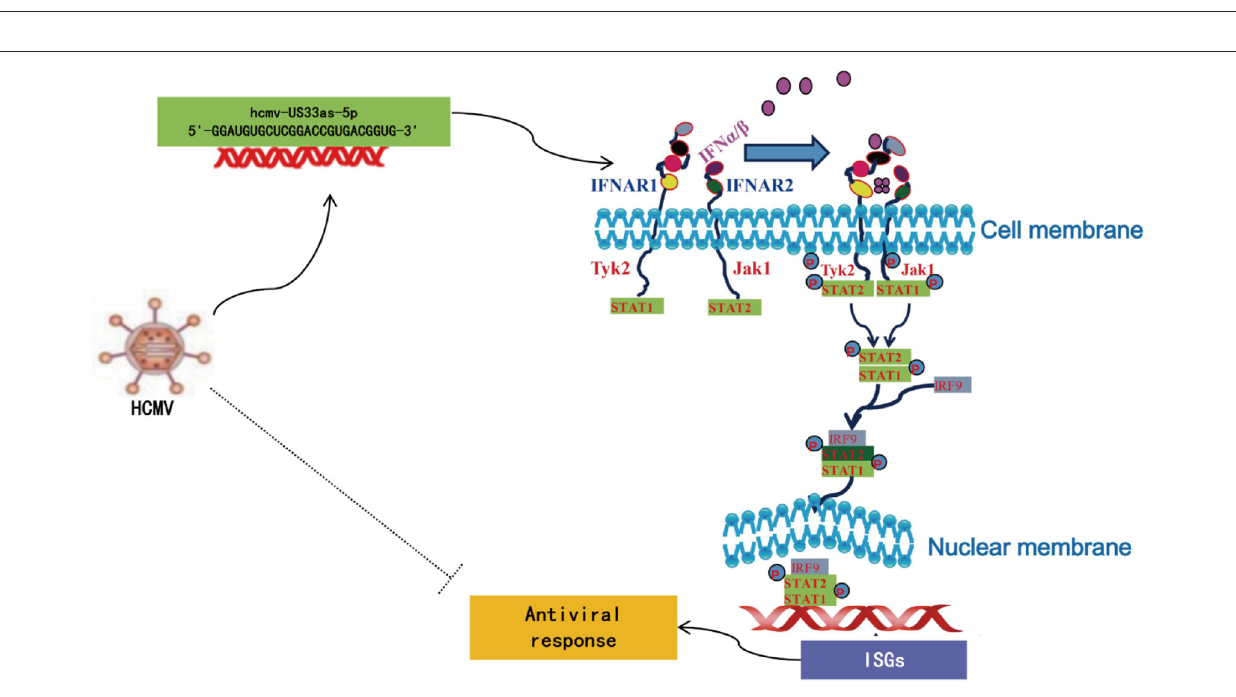
FIGURE 8 | culture medium supplemented with or without IFN (500 IU/mL). For viral reactivation, THP-1 cells were infected and maintained for 10 days in the culture medium. Then, the THP-1 cells were stimulated with TPA and further maintained in the medium for another 5 days. The cells were stimulated in a culture medium supplemented with or without IFN (500 IU/mL) beginning at 8 dpi. (B) The expression of miRNA among groups was examined by qPCR.THP-1 (C,D) The viral loads at indicated days were determined by qPCR and western blot. (E,F) The expression of IFNAR1 and ISGs (Mx1, RSAD2) among groups were determined by qPCR. ** p < 0.05.